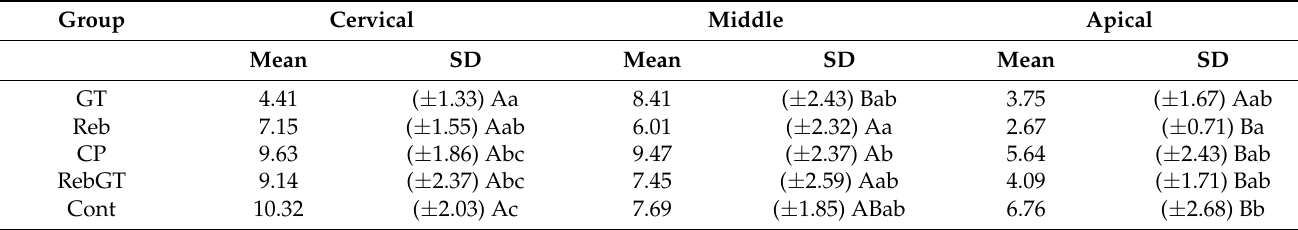
Table 2. Bond strength (MPa) mean and SD values for all groups tested. Group Cervical Middle